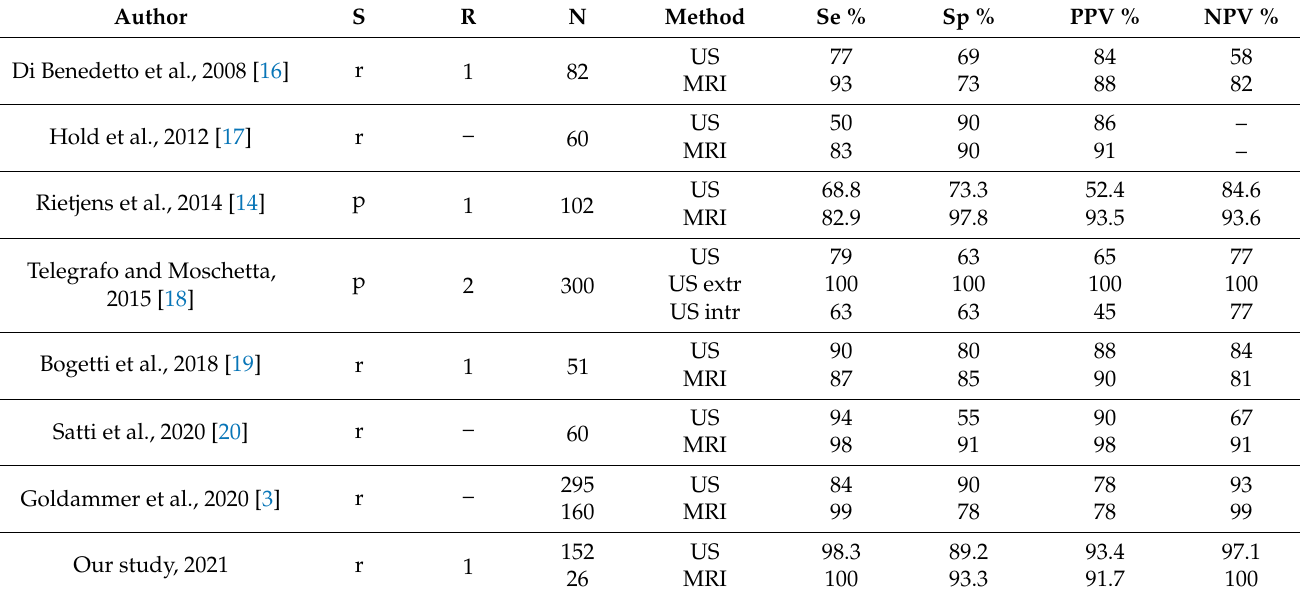
Table 5. Comparison of diagnostic discrimination of ultrasound and magnetic resonance